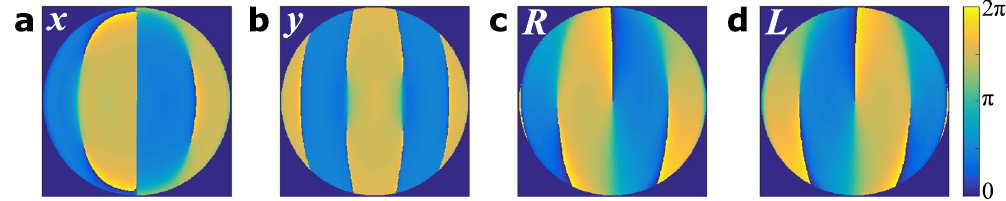
Figure 3. The phase of the optimal Eigenmode solutions for different polarizations. ( a – d ) are calculated for 2 μ m spheres with x , y , right circular ( R ) and left circular ( L ) respectively, with the trap optimized along the x axis. The optimal profiles clearly differ for the different polarizations, which could not be predicted using paraxial optics. Interestingly, the vortices in the right and left circular polarization profiles are all aligned together such that the profiles carry 3 ħ net orbital angular momentum. These profiles are mirror-images, with the orbital angular momentum in both cases opposing the spin angular momentum carried by the polarization.